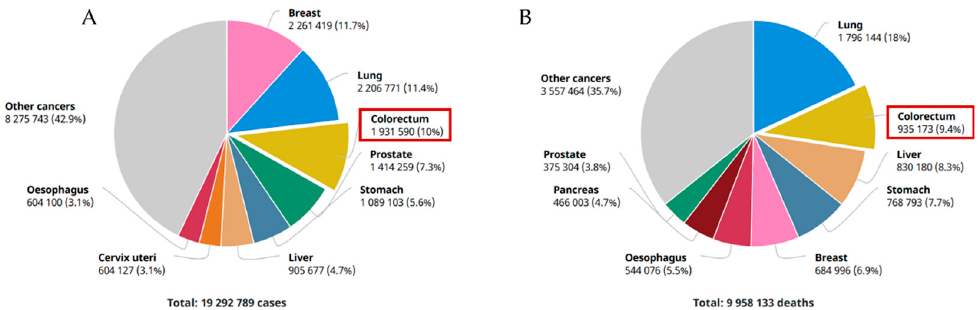
Figure 1. Incidence ( A ) and mortality rate ( B ) of CRC in 2020. Just under 2,000,000 people were diagnosed with CRC and around half of the cases resulted in death. Adapted from [9], with permission of the copyright holder.